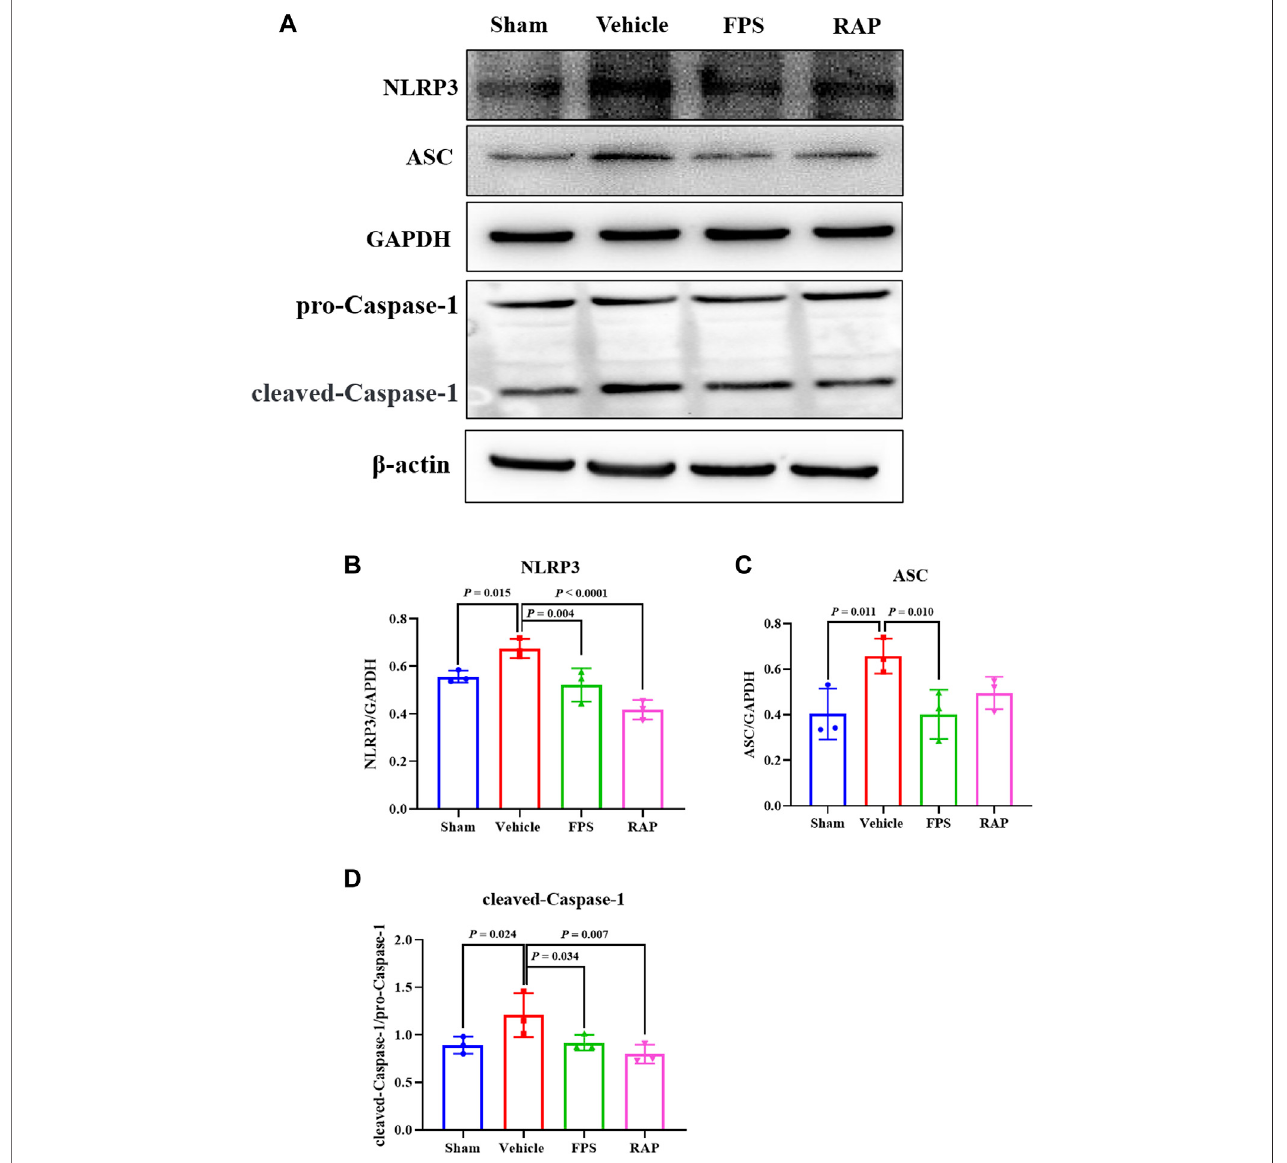
FIGURE 10 | Effects of FPS and RAP on the activation of NLRP3 in fl ammasome in vivo . (A) The WB analysis of NLRP3, ASC, pro-Caspase-1, and cleaved- Caspase-1 in the diabetic kidneys. (B – D) The rate of NLRP3, ASC, and cleaved-Caspase-1 to GAPDH or pro-Caspase-1, respectively. The data are expressed as the mean ±